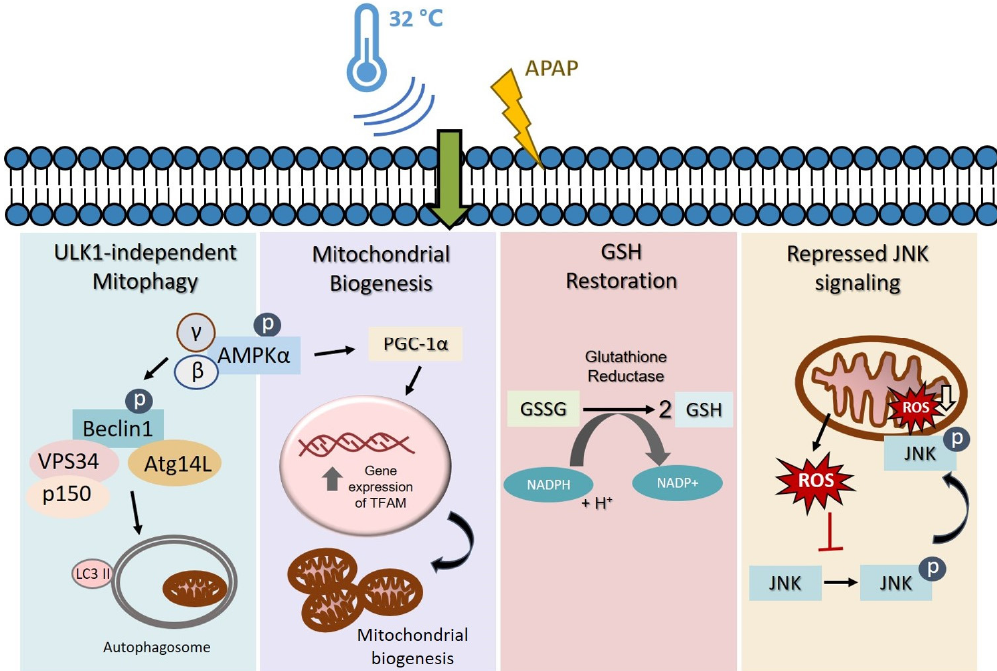
Figure 7. Proposed mechanism of action of moderate hypothermia (32 °C) in attenuating AIHI. Hypothermia conserves the pool of functional mitochondria through concomitant AMPK-mediated mitophagy and mitochondrial biogenesis. The ULK1-independent mitophagy aids in the removal of